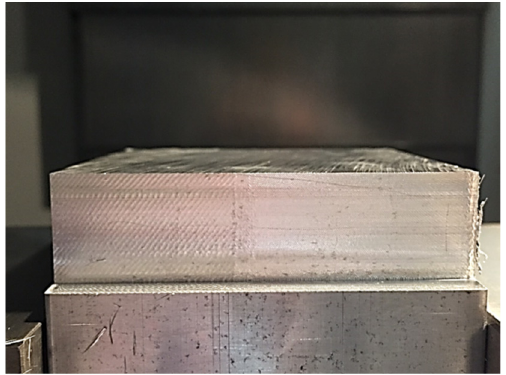
Figure 15. Effects of chatter suppression.